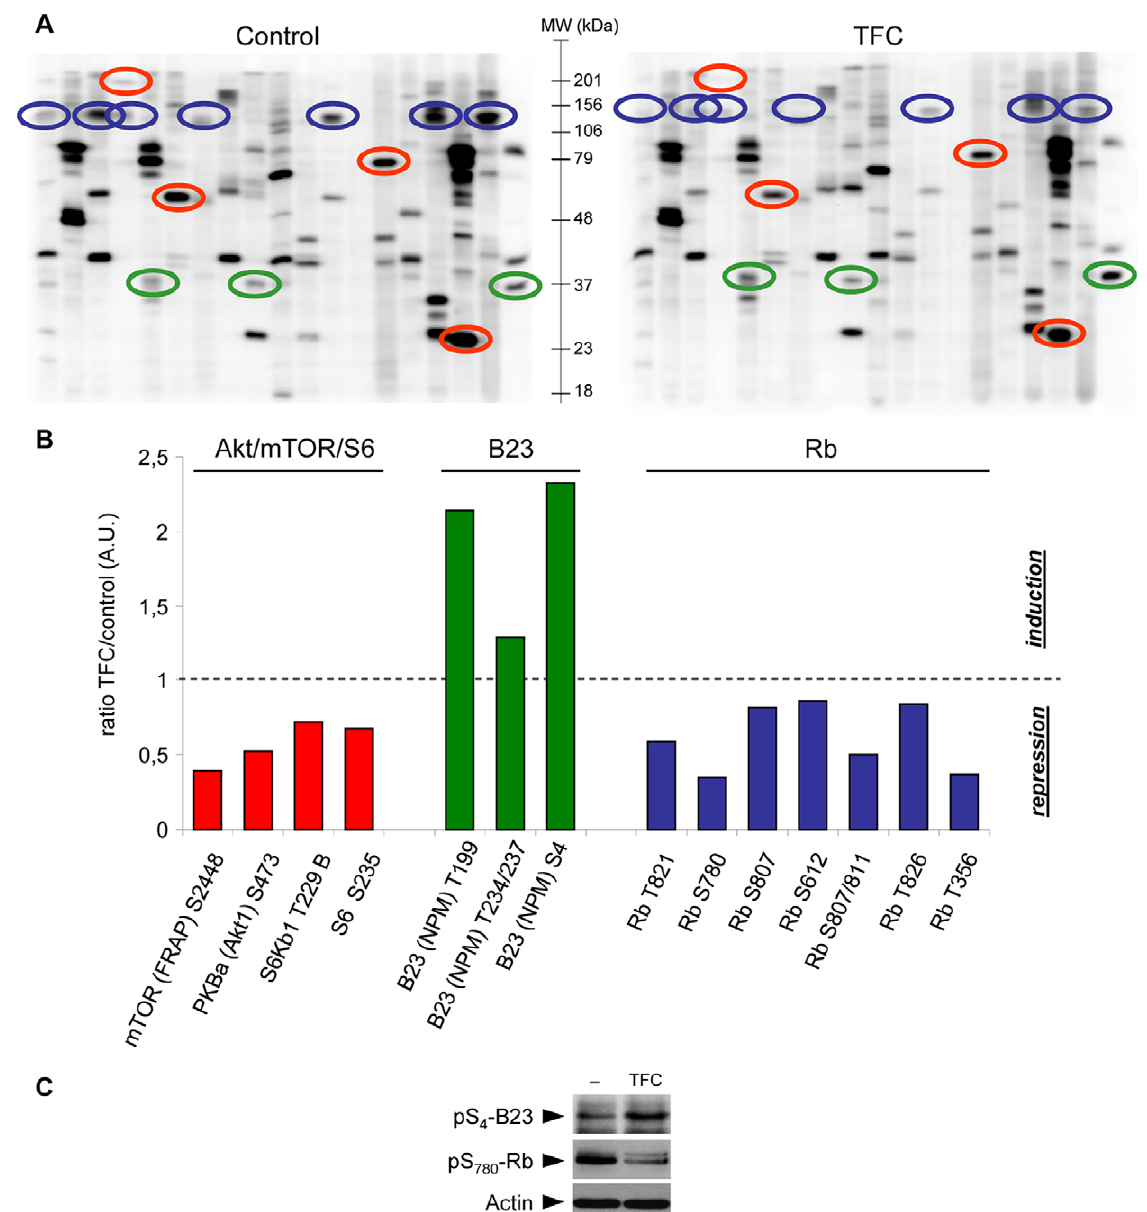
Figure 6. Triflorcas alters the phosphorylation status of cell cycle-related proteins. (A) The phosphorylation status of several cell cycle proteins was analyzed by applying the phospho-array KPSS 10.1 (Kinexus Bioinformatics). GTL-16 cells were treated with vehicle (control) or Triflorcas (TFC; 3 m M) for 72 hours (left and right panels, respectively). Red circles highlight constituents of the Akt/mTOR/S6 pathway. Green and blue circles surround nucleophosmin/B23 and Rb phospho-epitopes, respectively. (B) The graph shows the ratio of phosphorylation levels of the indicated proteins in cells untreated versus those exposed to Triflorcas. (C) Phosphorylation levels of nucleophosmin/B23 at Ser 4 and Rb at S 780 were increased and decreased, respectively, in GTL-16 cells exposed to Triflorcas (TFC; 3 m M for 24